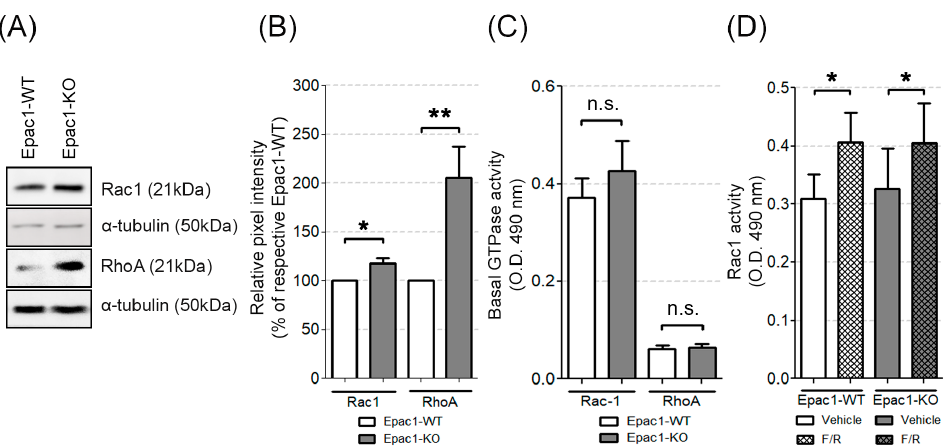
Figure 4. Basal protein levels and activation state of the small GTPases Rac1 and RhoA. ( A ) Western blot analysis of whole cell lysates for Rac1 and RhoA. Equal loading validation was monitored with α -tubulin; N ≥ 10. ( B ) Respective densitometric measurements of the band intensity. ( C ) Activity levels of basal Rac1 and RhoA assessed by G-LISA in WT and Epac1-KO cell lines; N ≥ 9. ( D ) Rac1 G-LISA activity measured in either DMSO or F / R treated WT and Epac1-KO cell lines; N = 8; * p ≤ 0.05, ** p ≤ 0.01; “n.s.” denotes non-significant di ff erences between the analyzed groups.